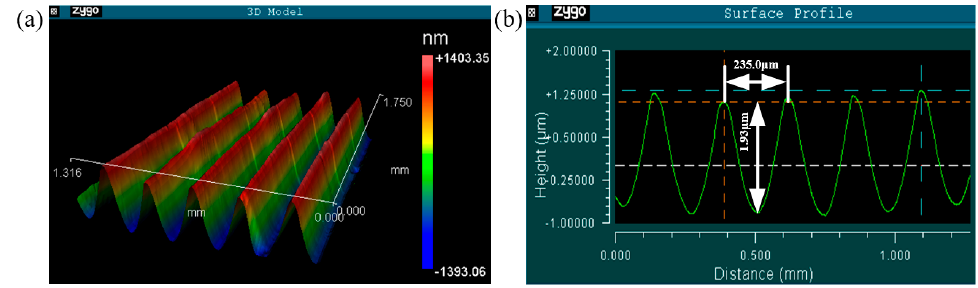
Figure 10. The morphology of fabricated array microgroove. ( a ) 3D contour; ( b ) Section profile. The surface roughness of the bottom of the microgroove is measured by the Mitutoyo SJ210 surface roughness meter. The measurements are taken along the length of the microgroove, with a sampling length of 0.08 mm, a detection length of 0.4 mm and a detection speed of 0.25 mm/s. Figure 11 plots the variation of measured surface roughness of the microgroove surface with distance. It can be seen from Figure 11 that the maximum height of profile ( R z ) is 34 nm, the arithmetical deviation of the profile ( R a ) is 5 nm, indicating that the surface of microstructure fabricated by UIP is very smooth. The detailed characterization of surface roughness of microgroove can also be found in recent work [35]. The textured surface combines the smoothing effect of UIP originally used for surface treatment, which is related to the mechanism of the UIP method: under the high-frequency and high-energy action of ultrasonic impact, the grains of the surface layer at a certain depth are broken and refined, the structure is strengthened and receives new distribution, and the surface produces uniform plastic deformation. Furthermore, the time interval between adjacent impacts is on the order of 10 − 5 s.